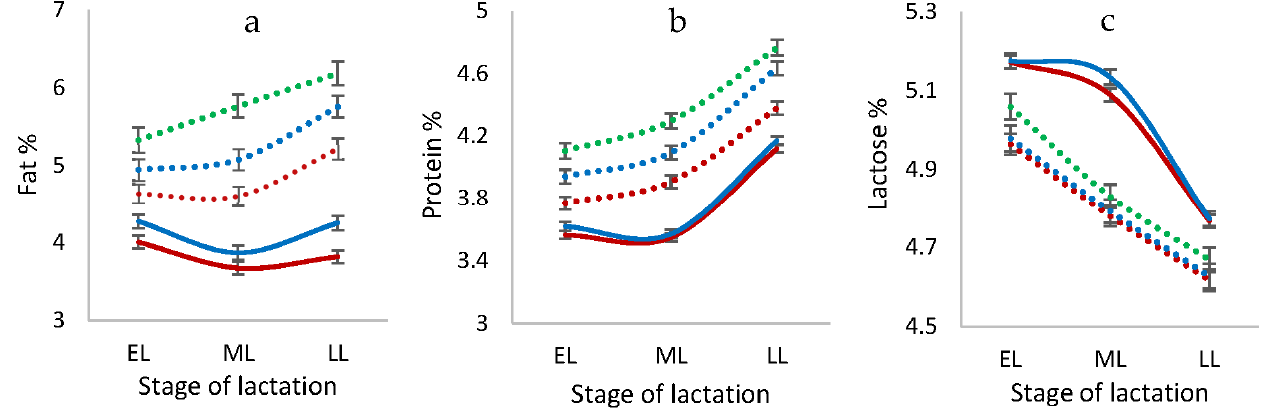
Figure 2. Percentages of ( a ) fat, ( b ) protein and ( c ) lactose in milk from Holstein-Friesian ( . . . . ), Holstein-Friesian × Jersey ( . . . . ) and Jersey ( . . . . ) cows milked OAD and Holstein-Friesian ( — ) and Holstein-Friesian × Jersey ( — ) cows milked TAD during the production season 2020–2021. EL = early lactation (<90 days); ML = mid-lactation (90–180 days); LL = late lactation (>180 days). The vertical bars show standard errors.